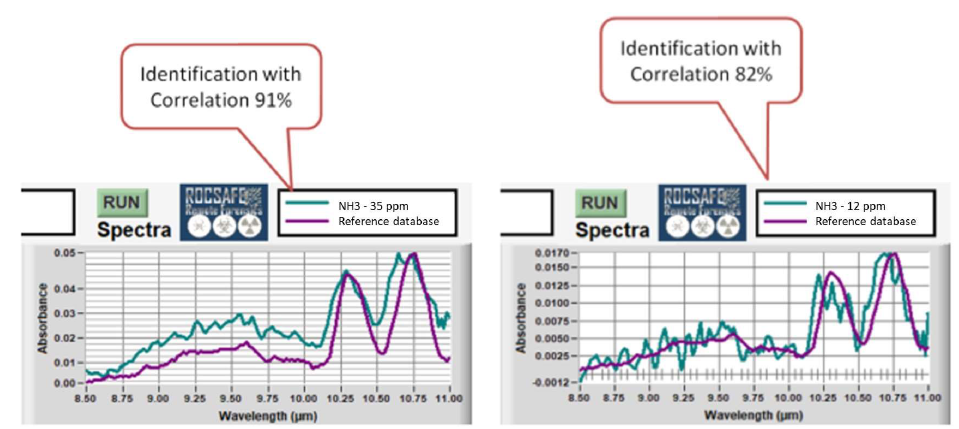
Figure 14. Screenshots of the LIRAS sensor’s GUI showing the identification of ammonia at 35 ppm (on the left ) and at 12 ppm (on the right ).